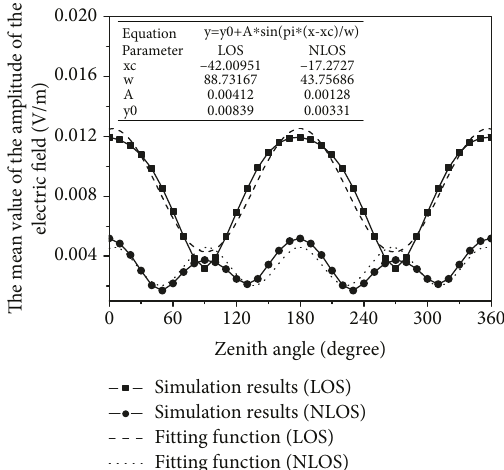
Figure 16: The mean value of the amplitude of the electric fi eld for di ff erent inclination angles in the LOS and NLOS corridors ( α = 90 ∘ ).